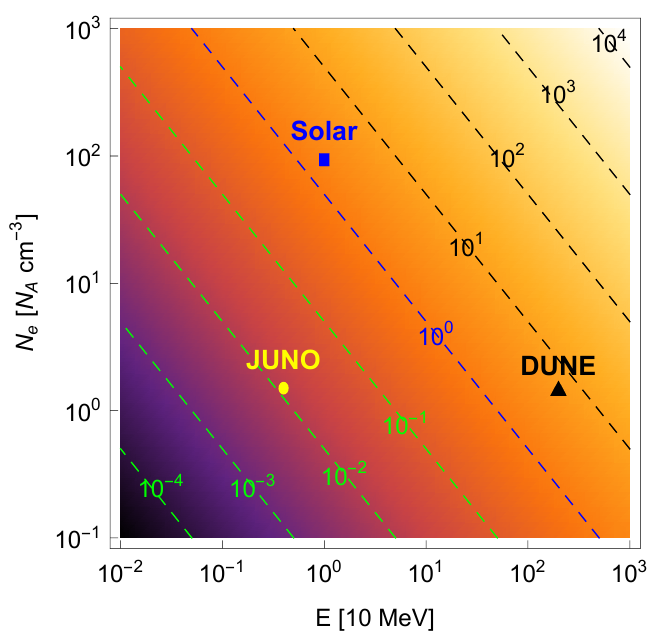
Figure 8 . The contours of a= (cid:1) neutrino energy E and the net electron number density N at ( E; N ) = (4 MeV ; 1 : 5 N e and the black triangle for DUNE at (2 GeV ; 1 : 5 N